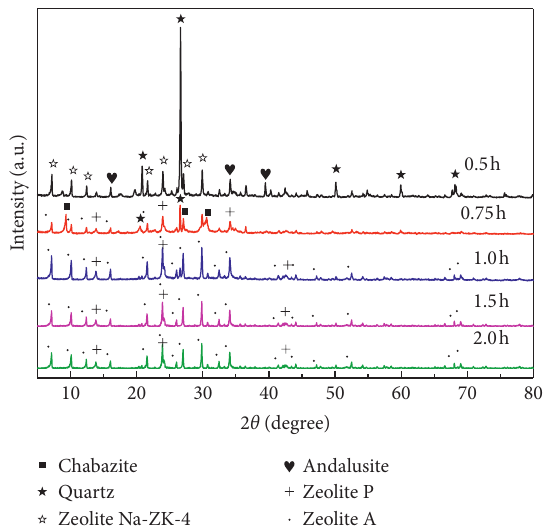
Figure 3: XRD patterns of the synthesized zeolites under various reaction periods (synthesis conditions: initial Si/Al ratio, 1.5; reaction temperature, 100 ° C). Table 2: Chemical composition analysis of the synthesized EMRZ under different